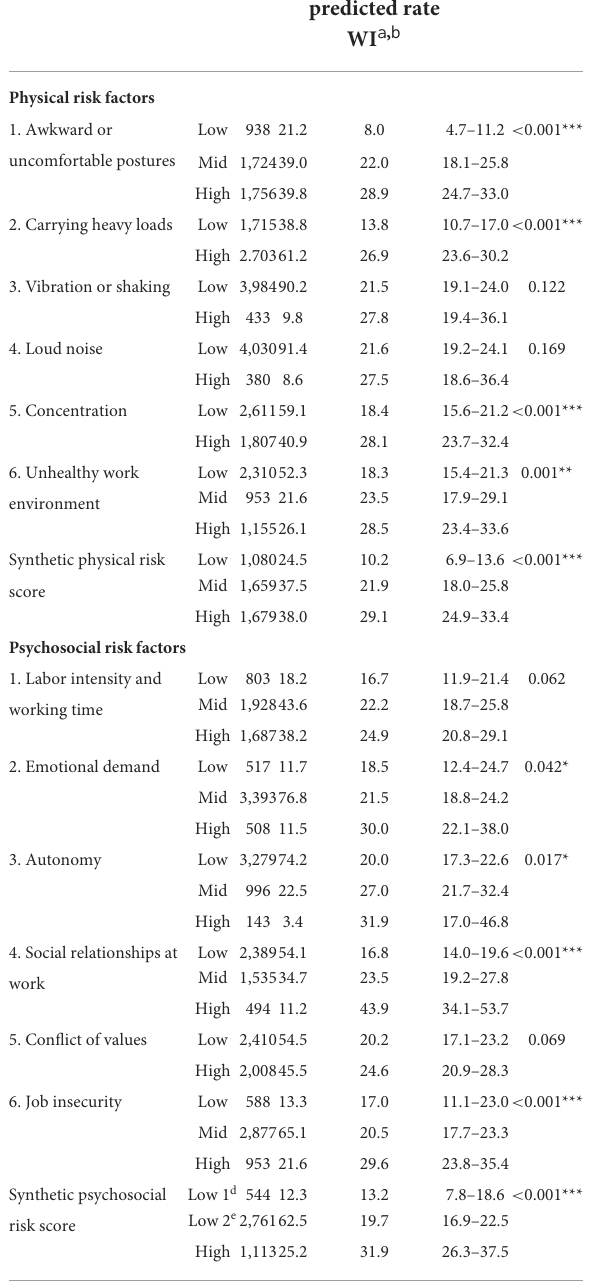
TABLE 3 Association between occurrence of workplace injuries (WI) during the period of follow-up and exposures to each physical and each psychosocial risk factors (PSF) among care